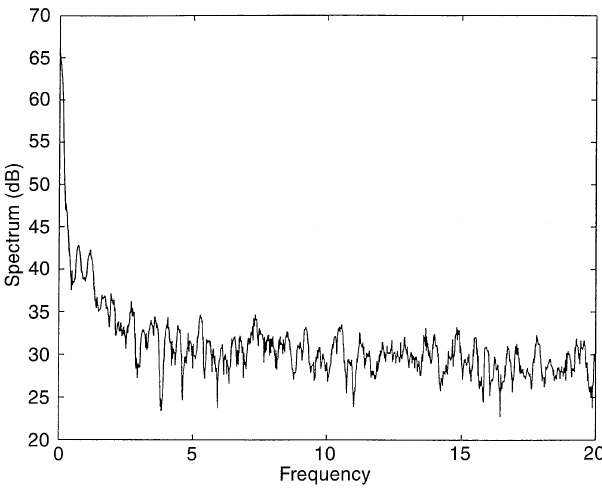
Fig. 15. Thompson analysis of the 30 March 1992 experiment (alti- tude 190.5 km); frequencies are in h